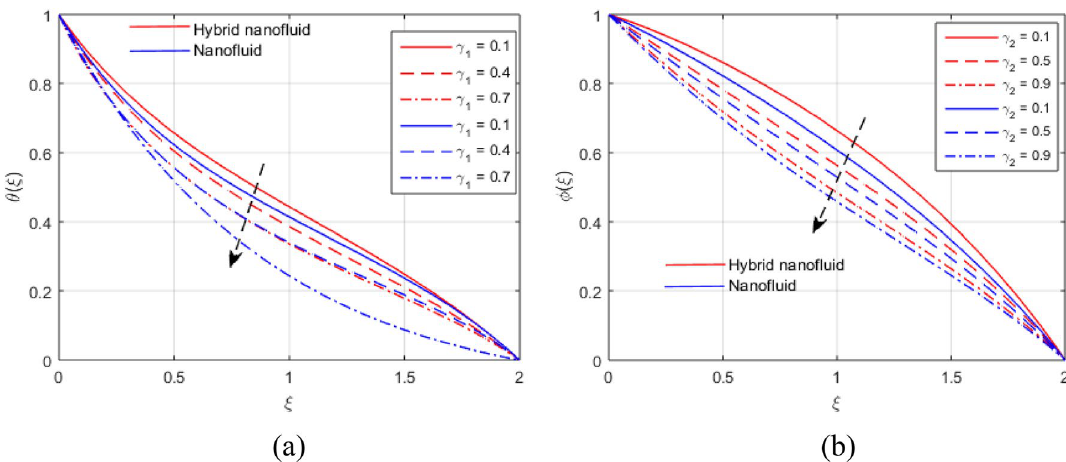
Figure 13. ( a , b ) Effect of γ 1 and γ 2 on θ(ξ) and φ(ξ)